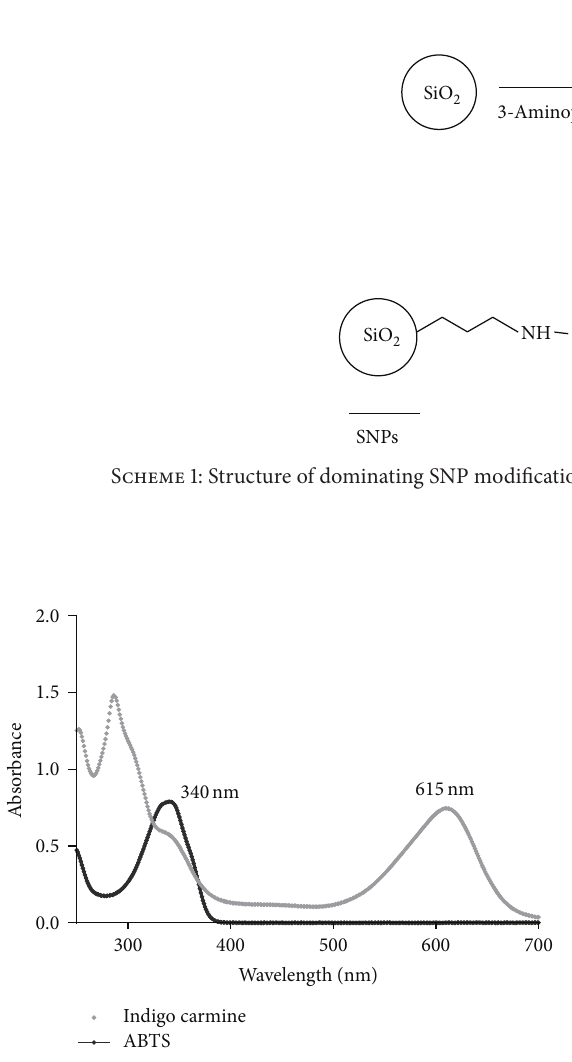
Figure2:TheabsorptionspectraofABTS(70 𝜇 MABTS)andindigo carmine (20mg/L) in 50 mM sodium acetate buffer at pH